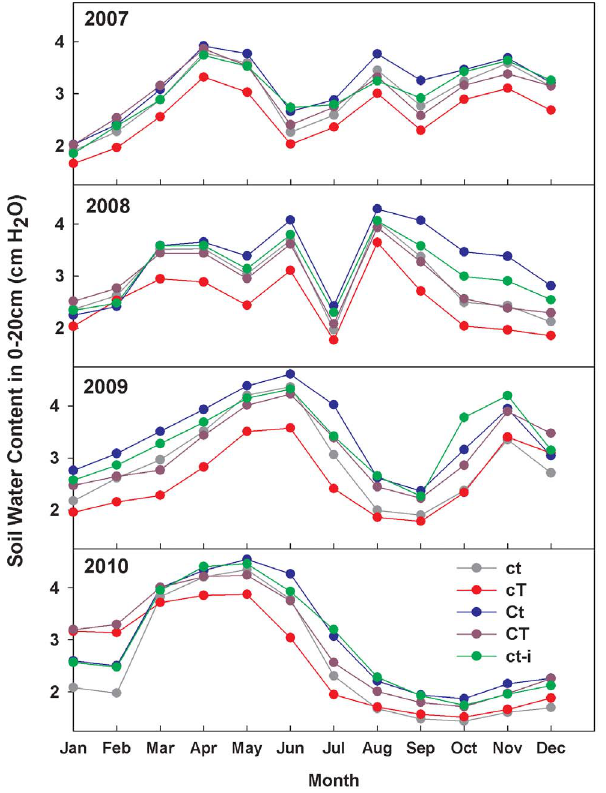
Figure 2. Monthly average soil water content in response to global changes. Mean monthly soil water content (SWC, 0–20 cm) for ambient and global change treatments (2007–2010). Treatment codes are ct=ambient temperature and ambient [CO 2 ]; cT=elevated tem- perature and ambient [CO 2 ]; Ct=ambient temperature and elevated [CO 2 ]; and CT=elevated temperature and elevated [CO 2 ]; ct-i=ambient temperature and ambient [CO 2 ] +